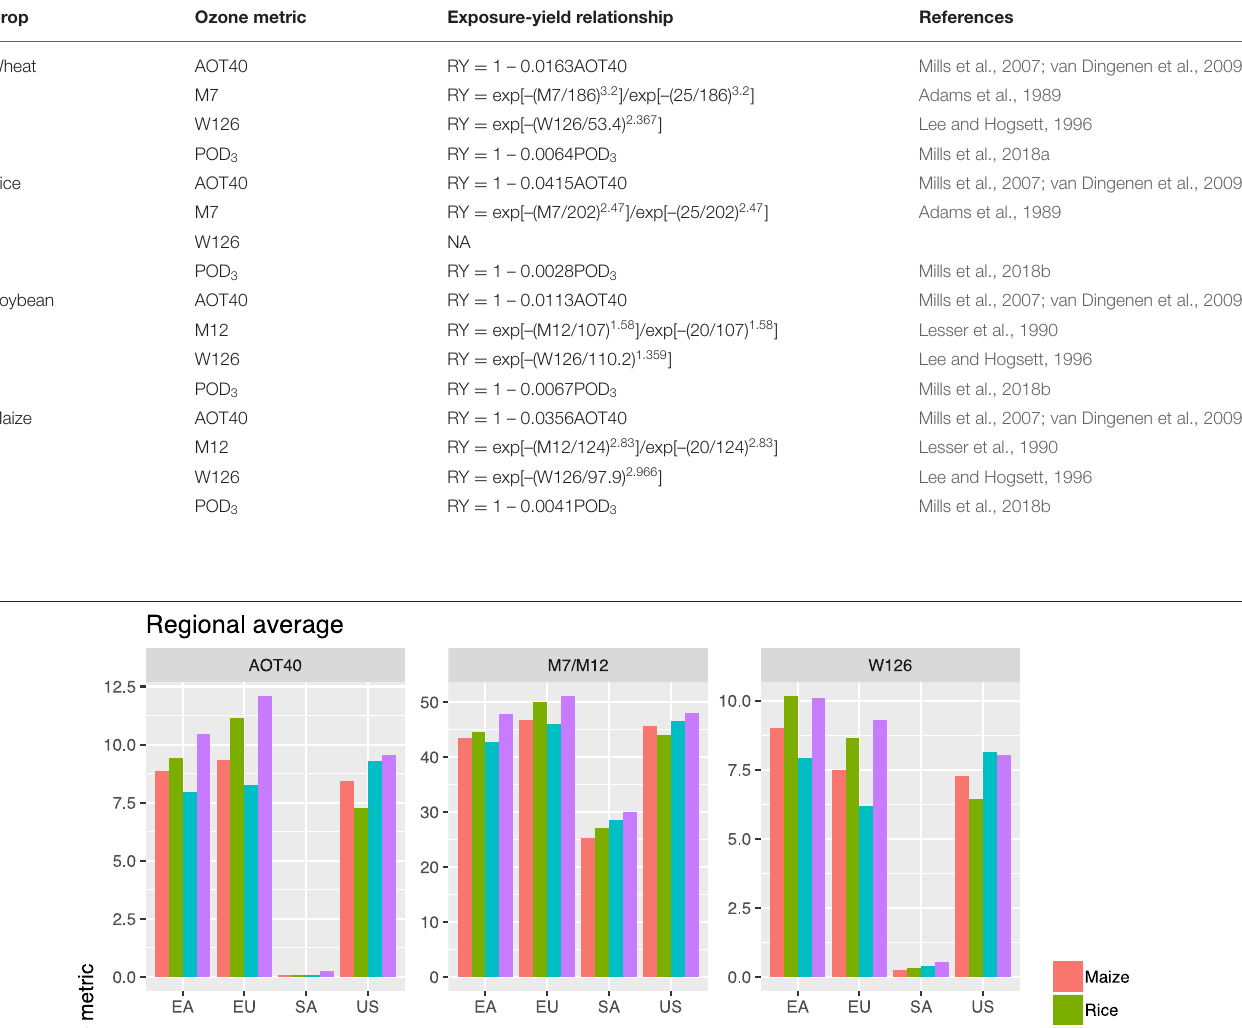
TABLE 1 | Statistical relationships between relative yield (RY) and ozone exposure metrics. Crop